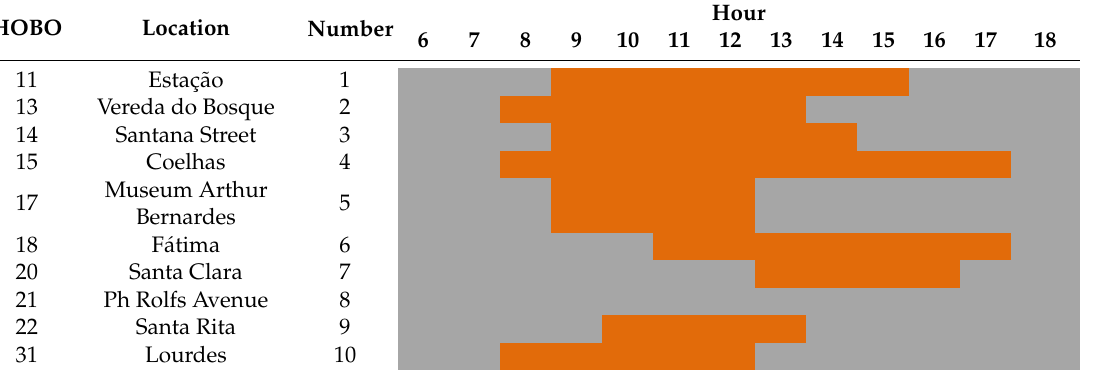
Table 3. Direct radiation time at the collection points in the municipality of Viçosa-MG.